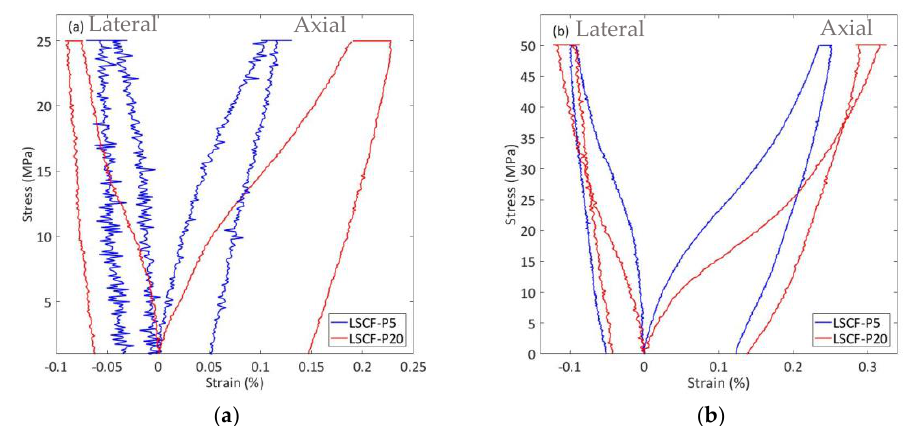
Figure 3. Comparison of axial and lateral stress–strain curves of samples with different porosity and maximum stresses of ( a ) 25 MPa and ( b ) 50 MPa. Table 1. Sample preparation conditions, porosity and ferroelastic mechanical parameters.